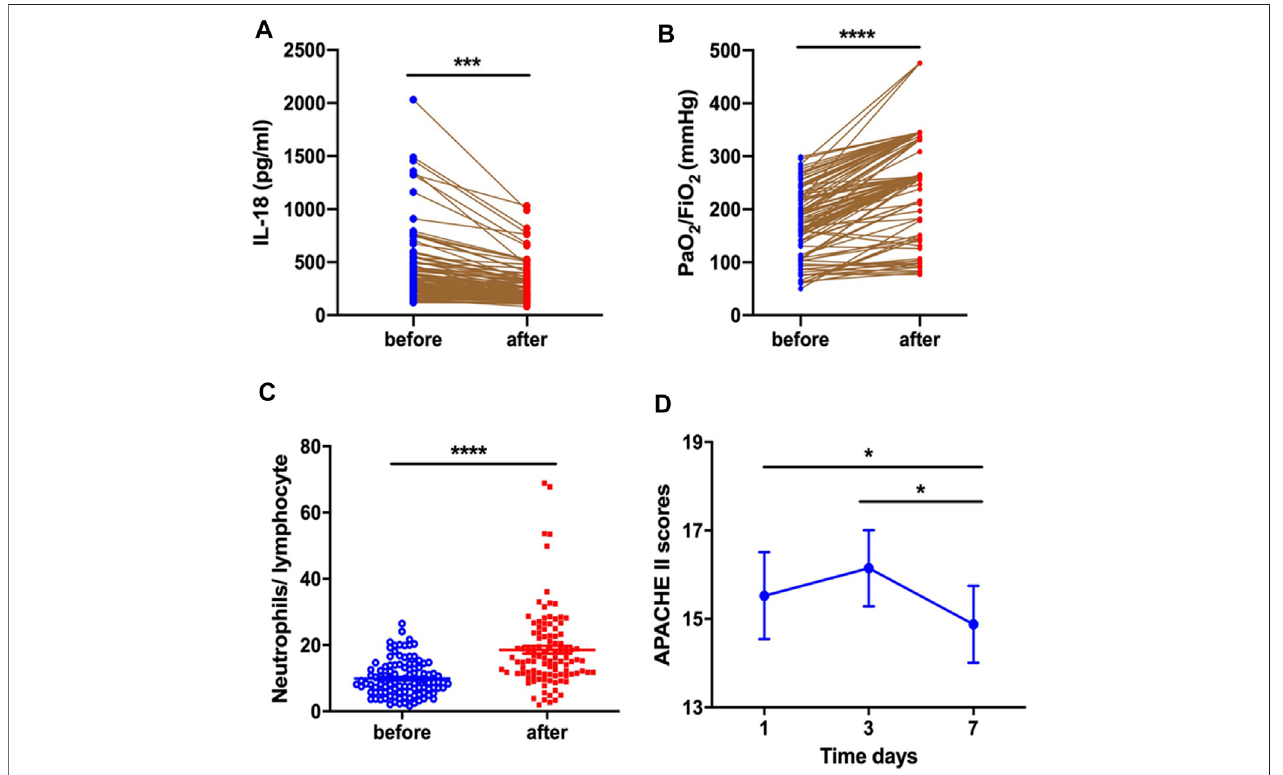
FIGURE 1 | Corticosteroid treatment decreased serum IL-18 level (A) and improved PaO 2 /FiO 2 (B) , increased the neutrophil-to-lymphocyte ratio (C) , and decreased APACHE II score (D) at the seventh day.